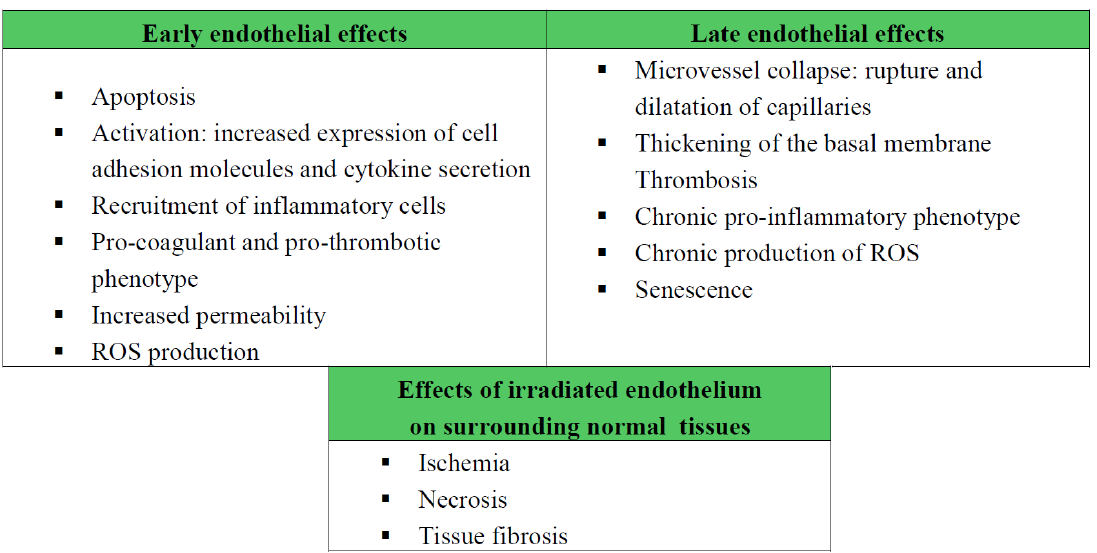
Figure 1. Early and late effects of ionizing radiations on endothelial cells. Relevance in tissue radiation